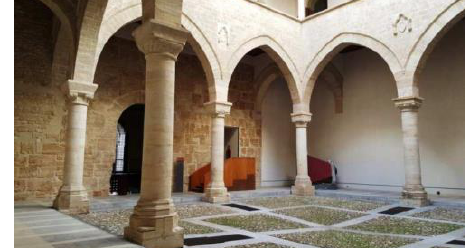
Figure 1. Ground floor of the courtyard, tuff bricks columns